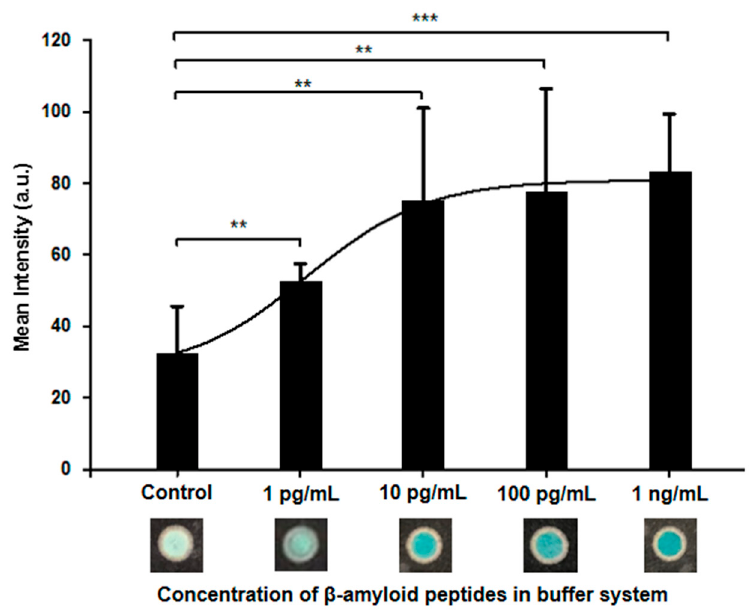
Figure 1. Colorimetric results (intensity) from our paper-based ELISA (P-ELISA) test for β -amyloid peptide 1-42 (A β 42) concentrations in a buffer system. The color intensity difference between our 1 pg / mL A β 42 concentration and our control was very significant. (** p < 0.01; *** p < 0.001).